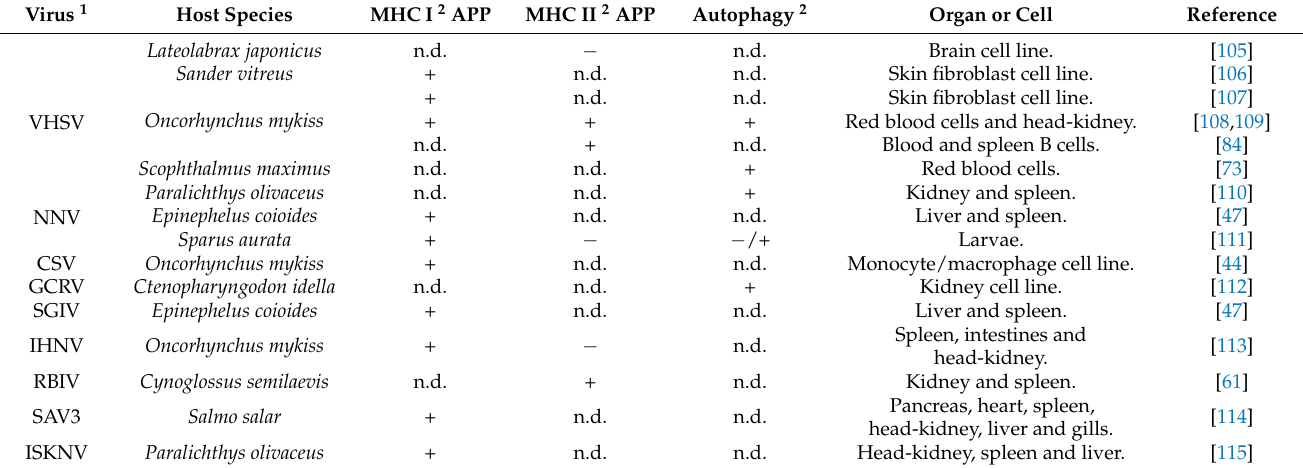
Table 1. Modulation of expression of genes involved in antigen processing and presentation (APP) MHC class I and II pathways and autophagy during infection of teleost fish species with viral